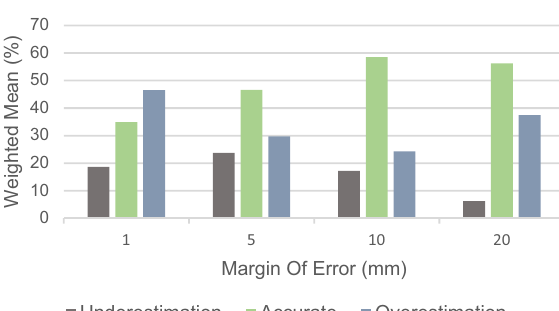
Accurate Overestimation Fig. 2 Percentage of concordance between MRI and pathology. Weighted mean percentage of concordance, overestimation and underestimation between MRI and pathology measurements in the 12 studies with different prede fi ned margin of error, according to Table 2 ( A ). Weighted mean percentage of concordance, over- estimation and underestimation between MRI and pathology measurements in 11 studies with equal prede fi ned margin of error ( B